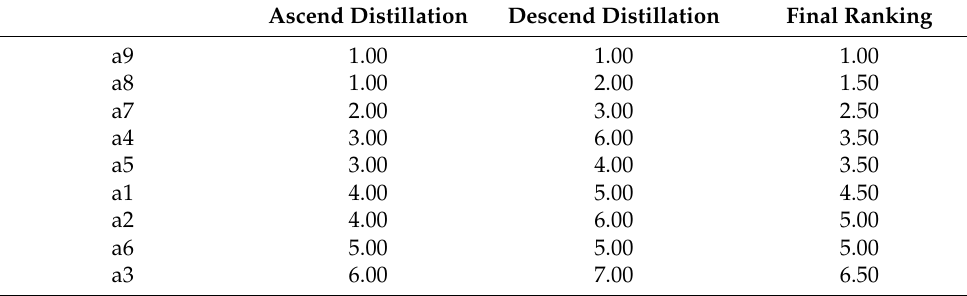
Table 7. Final survey